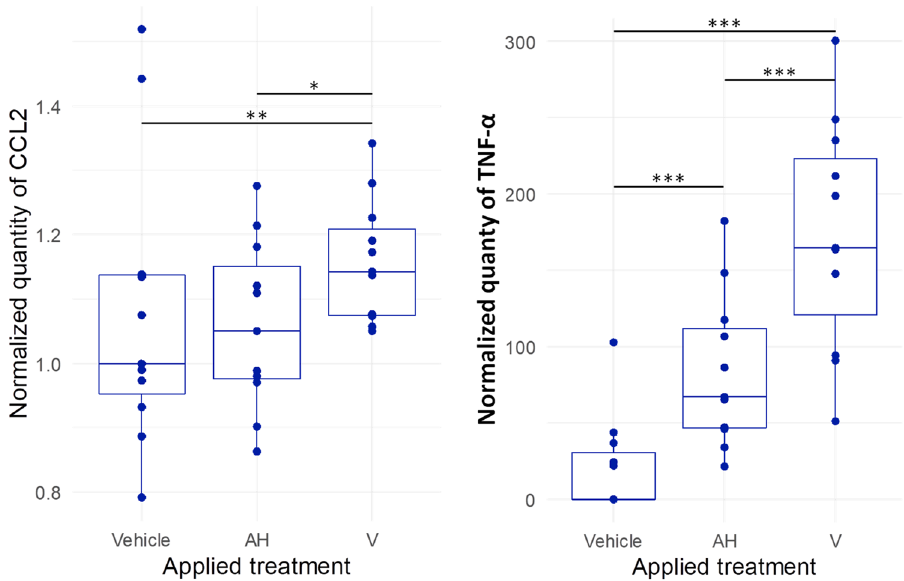
Figure 3. Expression level of CCL2 (left panel) and TFN-α (right panel) into differentiated PBMCs exposed 4 h Al-based treatments. AH, Aluminum oxyhydroxide. V, Whole vaccine (Engerix ® ). *statistical differences at Durbin-Conover post-hoc test (* p < 0.05, ** p < 0.01, *** p < 0.001).